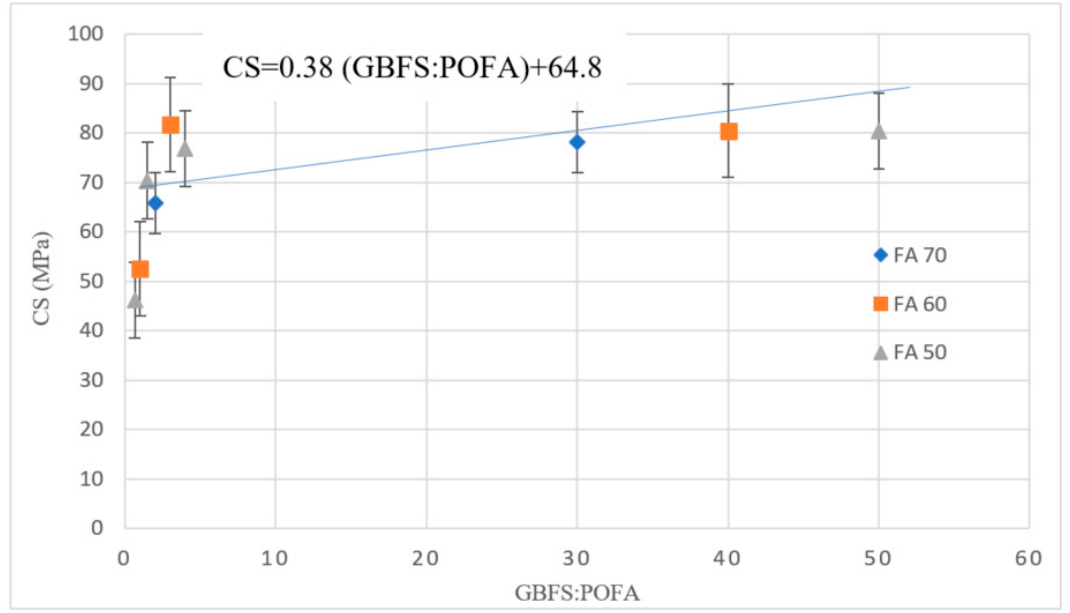
Figure 3. CS of AAM designs with a high volume of FA.